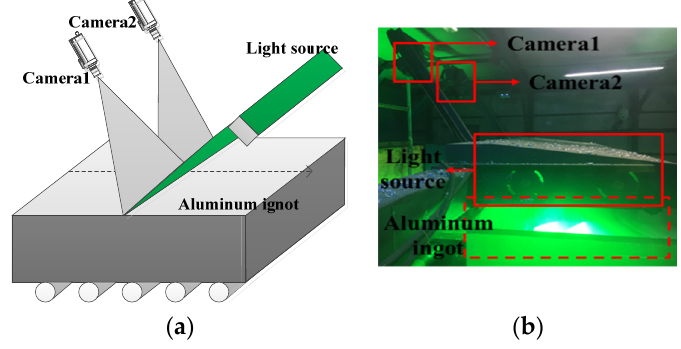
Figure 21. The imaging system: ( a ) a concise diagram and ( b ) picture of the material